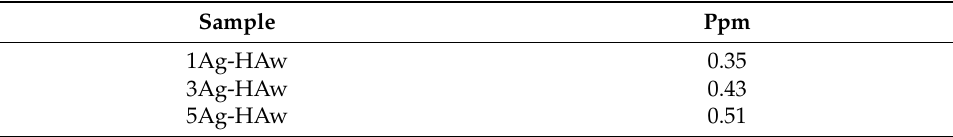
Table 4. Dissolution of silver